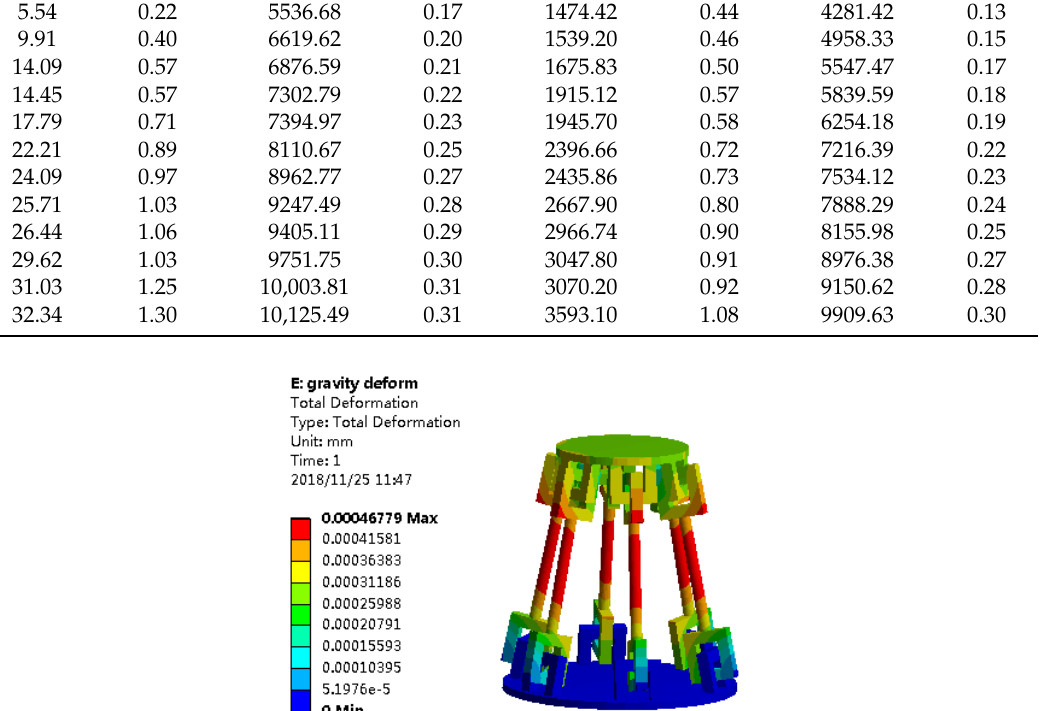
Table 2. Partial force/torque values corresponding to deformation values.